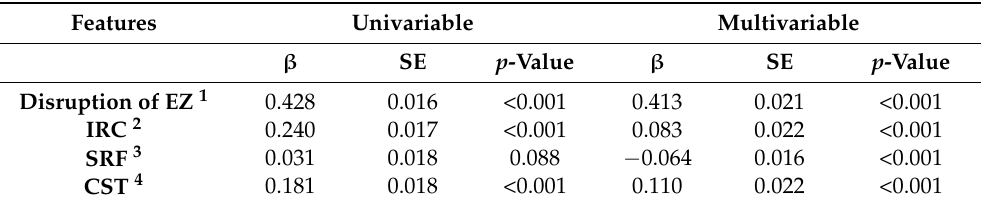
Table 4. Linear regression results for VA (logMAR-BCVA) in relation to OCT-derived retinal features (EZ disruption, IRC, and SRF). Features Univariable Multivariable β SE p -Value β SE p -Value Disruption of EZ 1 0.428 0.016 <0.001